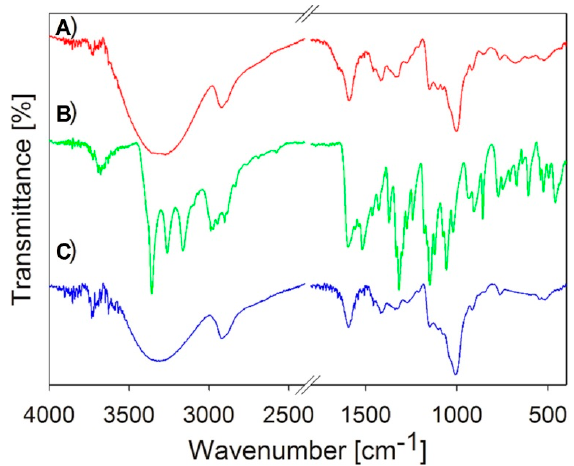
Figure 2. FT-MIR spectra of hydrochlorothiazide stabilized with 5% carboxymethyl dextran sodium salt (sample 5c , A ); bulk hydrochlorothiazide ( B ) and carboxymethyl dextran sodium salt ( C ).